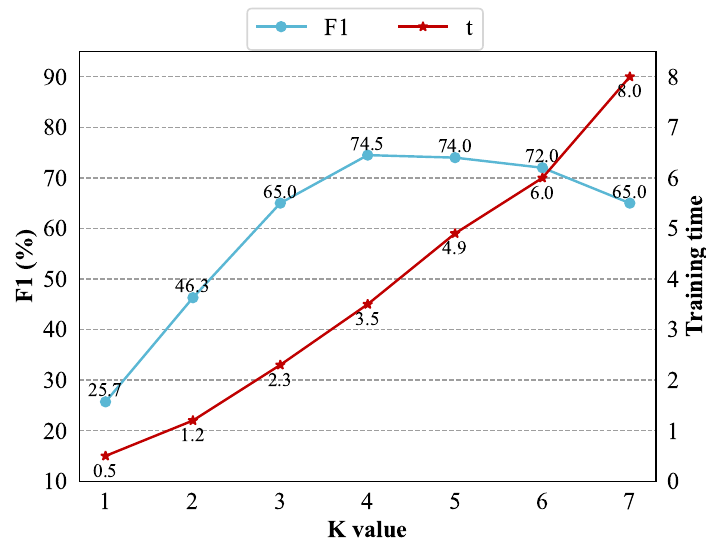
Figure 7. Effects of different K values on model